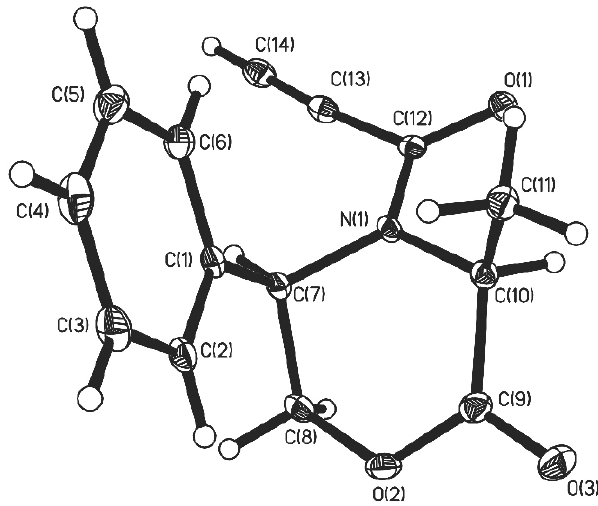
Table 1. Data collection and handling.